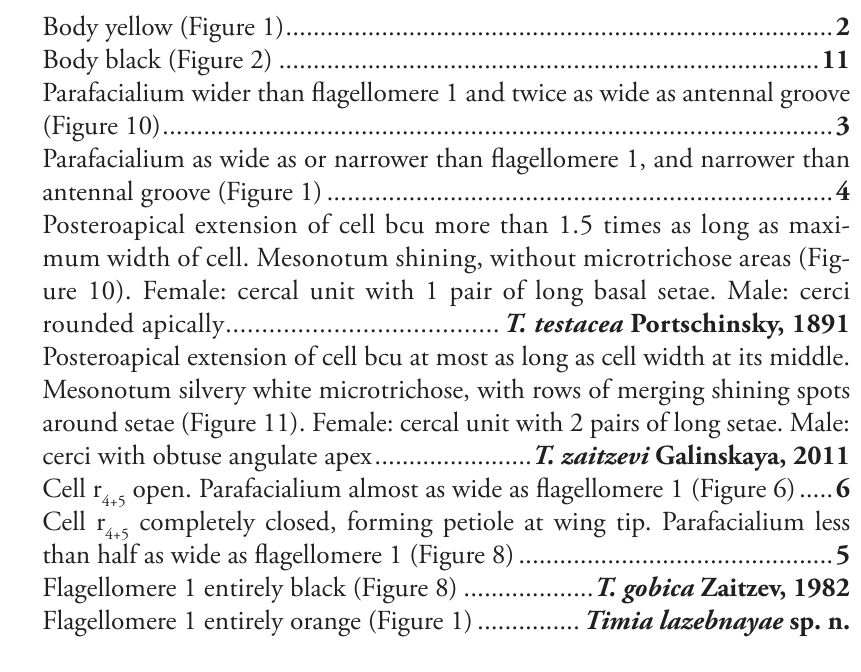
Parafacialium wider than flagellomere 1 and twice as wide as antennal groove (Figure 10) .................................................................................................. 3 – Parafacialium as wide as or narrower than flagellomere 1, and narrower than antennal groove (Figure 1) .......................................................................... 4 3 Posteroapical extension of cell bcu more than 1.5 times as long as maxi- mum width of cell. Mesonotum shining, without microtrichose areas (Fig- ure 10). Female: cercal unit with 1 pair of long basal setae. Male: cerci rounded apically ...................................... T. testacea Portschinsky, 1891 – Posteroapical extension of cell bcu at most as long as cell width at its middle. Mesonotum silvery white microtrichose, with rows of merging shining spots around setae (Figure 11). Female: cercal unit with 2 pairs of long setae. Male: cerci with obtuse angulate apex ....................... T. zaitzevi Galinskaya, 2011 4 Cell r open. Parafacialium almost as wide as flagellomere 1 (Figure 6) ..... 6 4+5 – Cell r completely closed, forming petiole at wing tip. Parafacialium less 4+5 than half as wide as flagellomere 1 (Figure 8) ..............................................